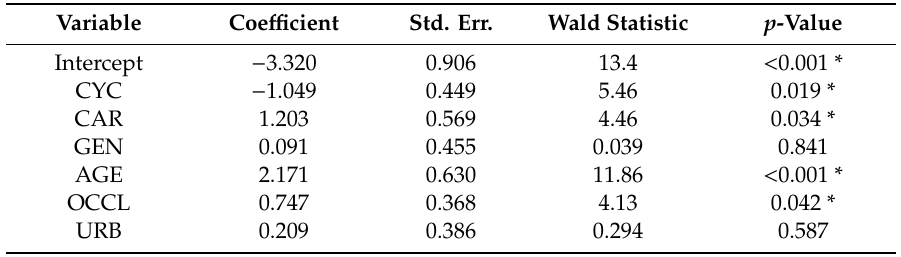
Table 2. Estimated coe ffi cients, estimated standard errors, p -values and Wald statistic for the model